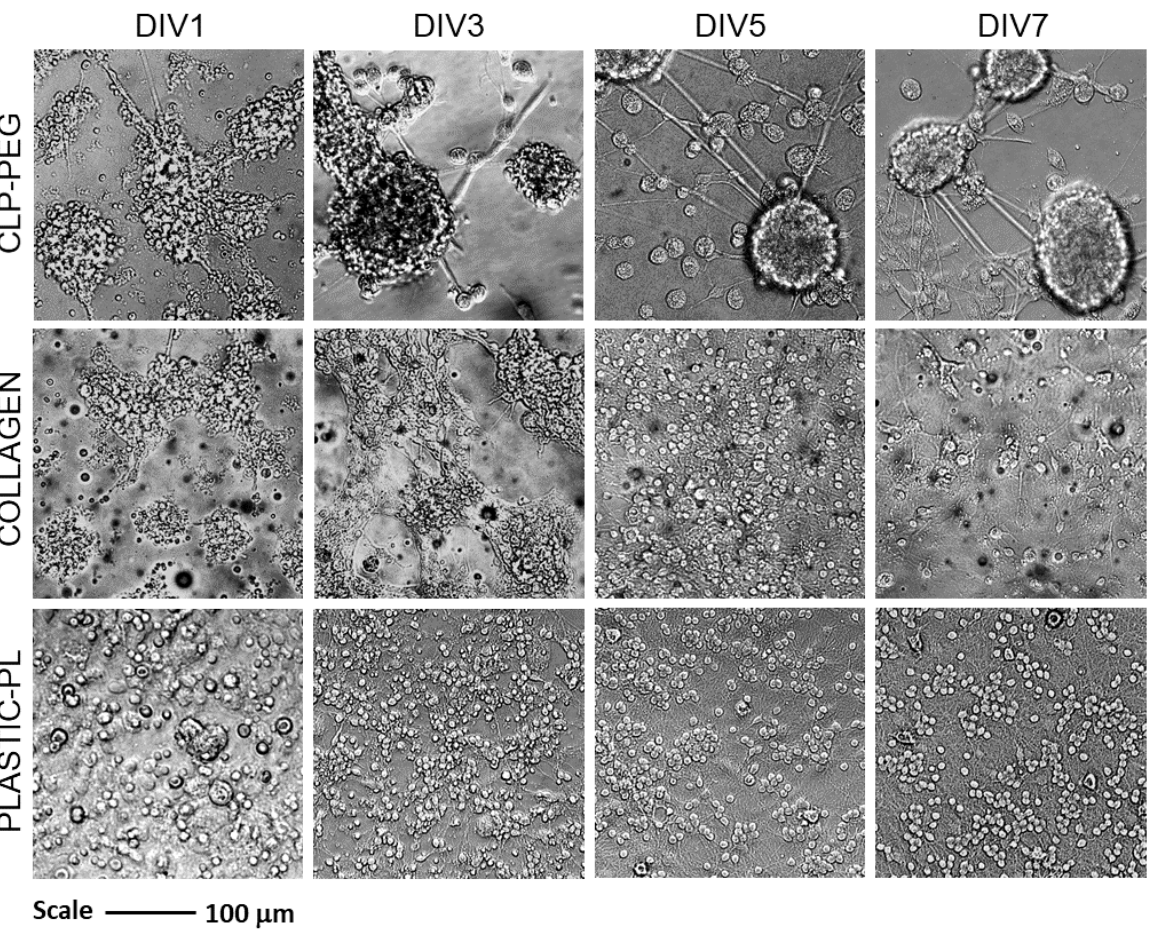
Figure 3. Representative brightfield microscopy images of cerebellar cell cultures on CLP-PEG and collagen hydrogels and on poly- L -lysine (PL) coated tissue culture plastic after 1, 3, 5 and 7 days in vitro (DIV).